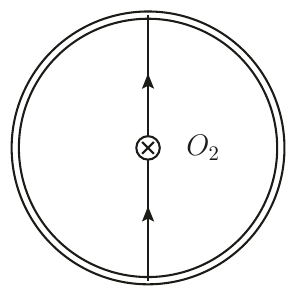
Figure 6 . Tree level contribution to the one-point function of O 2